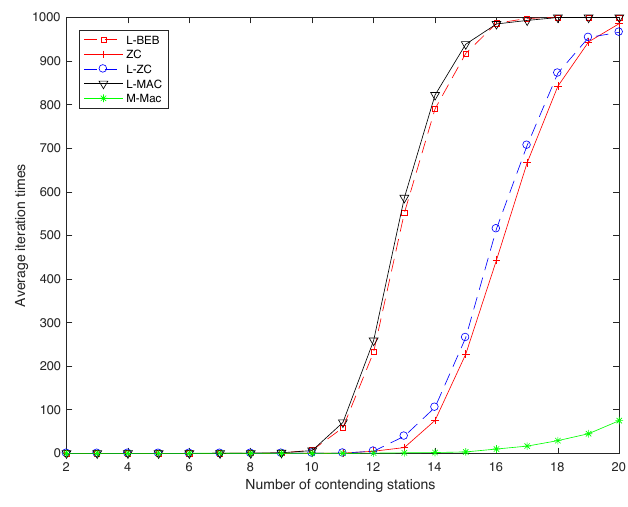
Figure 12. Collision-free speed of